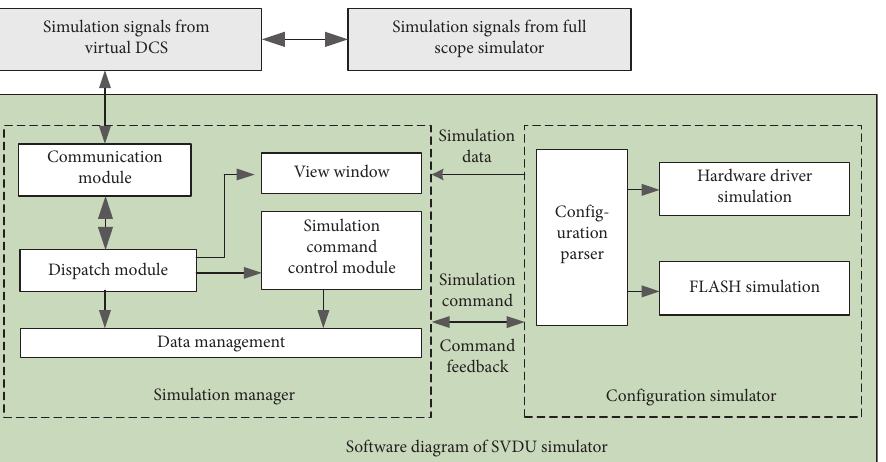
Figure 7: Software block diagram of the SVDU